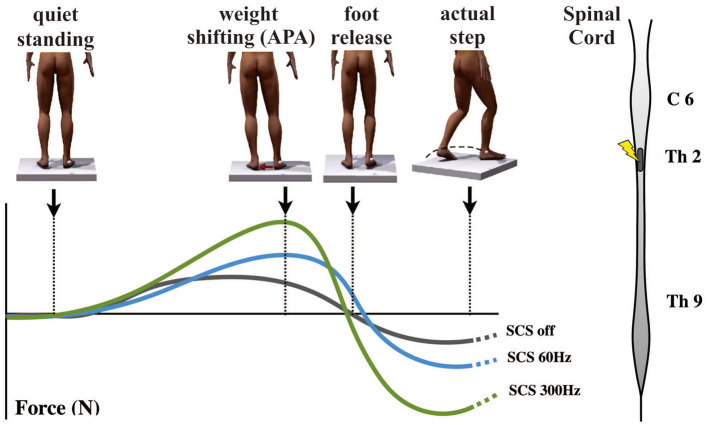
Effects of spinal cord stimulation on postural control in Parkinson's disease patients with freezing of gait (132). On the top left, the figures show the representation of the step initiation task from quiet standing to the actual step, showing the marker on the right malleolus to detect the moment that the foot clears the floor. The graph below shows body weight shifting toward the supporting leg [anticipatory postural adjustment (APA)] during the three different conditions [gray curve, spinal cord stimulation (SCS) OFF; blue curve, 60 Hz-CS; green curve, 300 Hz-SCS]. On the right is a representation of the spinal cord showing the site of stimulation (T2) used in the same report.